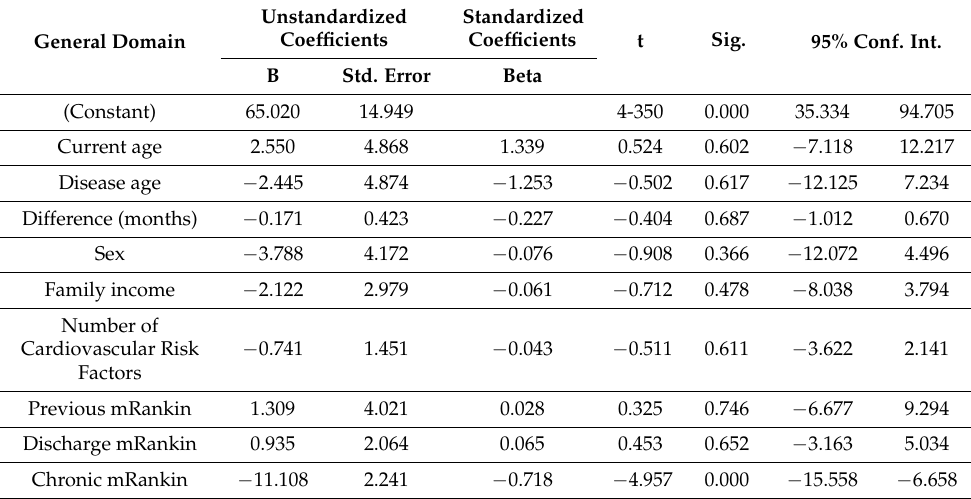
Table 7. Multivariate analysis for General domain.